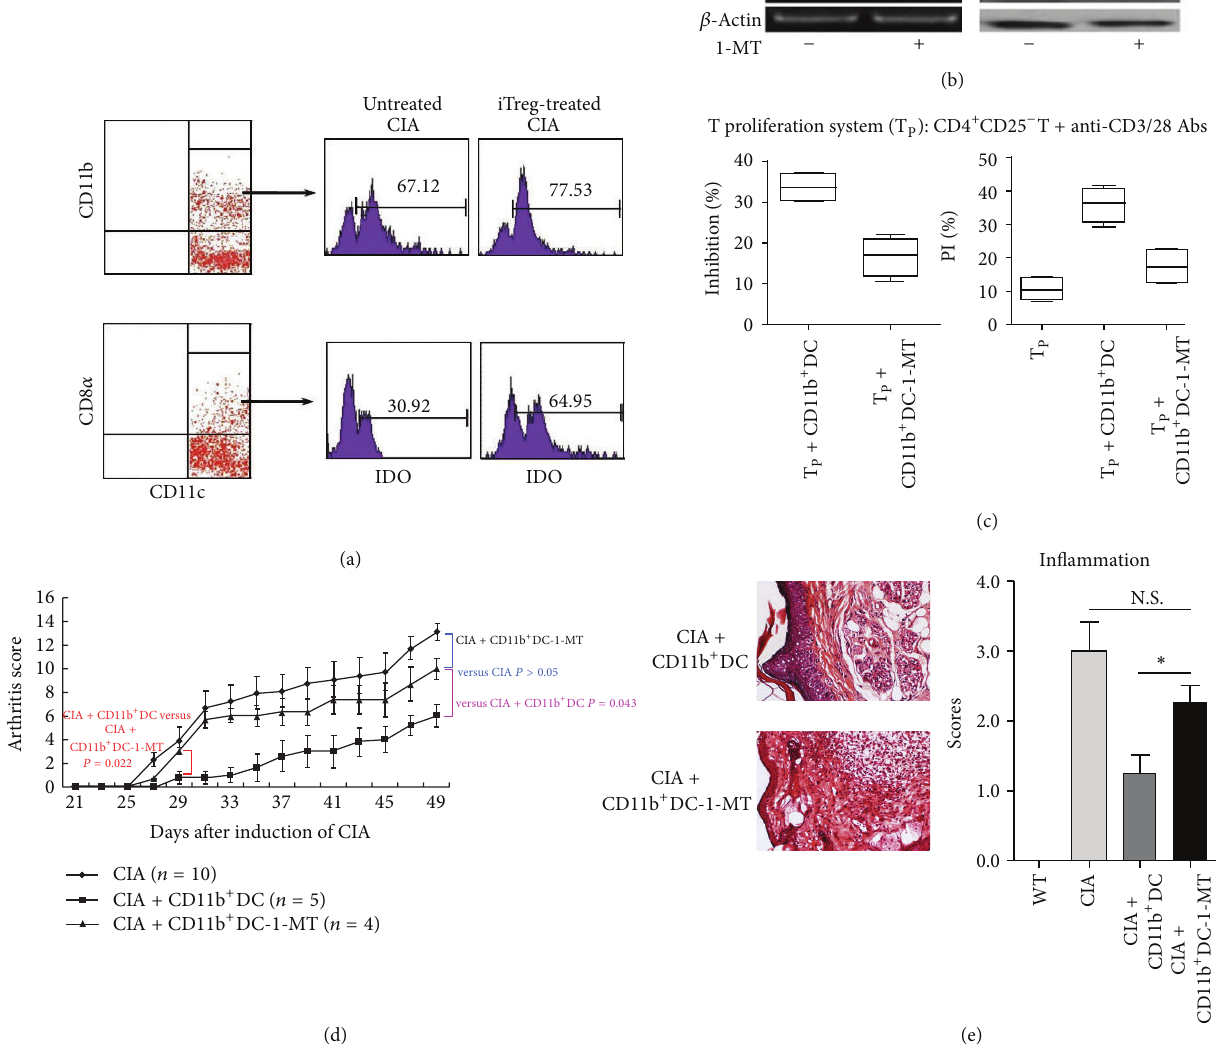
Figure 4: The adoptive transfer of iTregs promoted IDO secretion in splenic DCs and the further suppression of CIA. (a) IDO expression levels in CD11b + DCs and CD8 𝛼 + DCs from iTreg-treated CIA mice were determined using FACS. The corresponding DC subsets from untreated CIA mice were used as controls. (b) The results of RT-PCR and Western blotting showed the expression of IDO in CD11b + DCs after blocking with 1-MT. (c) CD11b + DCs were pretreated with 1-MT to block IDO expression and were subsequently added to the CD4T proliferation system. Four days after cocultivation, CFSE + CD 4 + T cells were stained with propidium iodide (PI) and analyzed using flow cytometry. The error bars indicate SEM. The results of 4 replicated experiments were pooled. (d) Recipient mice subjected to the adoptive transfer of CD11b + DCs, with or without 1-MT treatment, were sacrificed 49 days after the first CII immunization. The arthritic scores in each group are shown ( 𝑛 = 5 ). (e) Histopathological examination of the joints of mice described in (d) after H&E staining to visualize inflammatory cell infiltration. The histopathological inflammation scores are expressed as the means ± SEM of five independent experiments. ∗ 𝑃 < 0.05 compared with the indicated groups using unpaired t